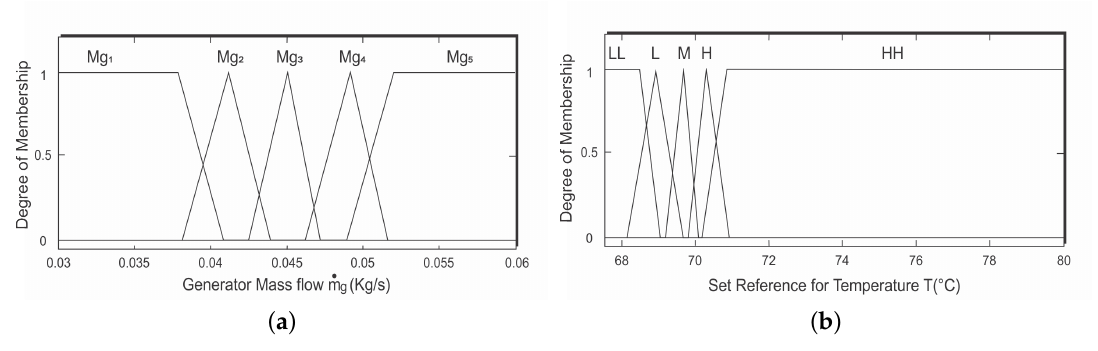
Figure 12. Output fuzzy set membership function for generator mass flow and input temperature reference to the fuzzy control of solar collector, respectively. ( a ) Output set reference for generator mass flow; ( b ) output set reference for temperature for fuzzy control of solar